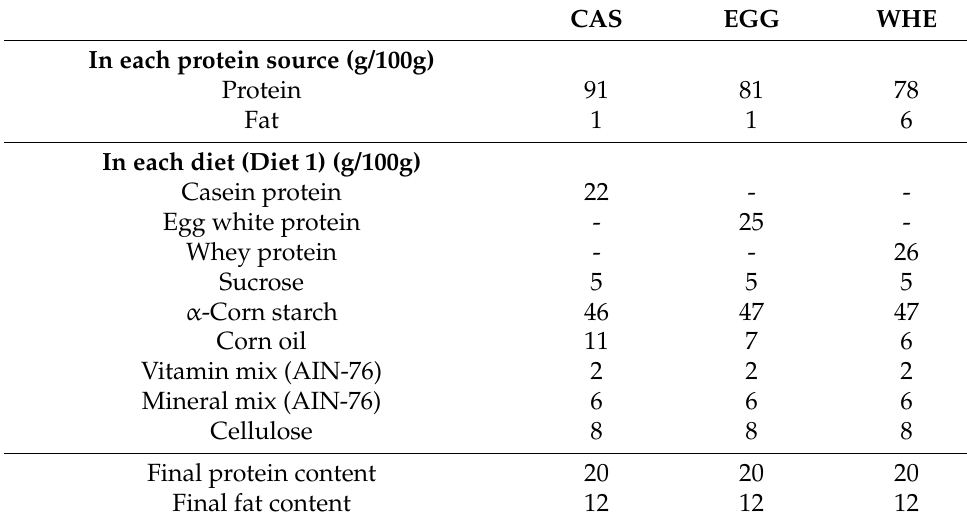
Table 1. Composition of nutrients in protein sources and diets.